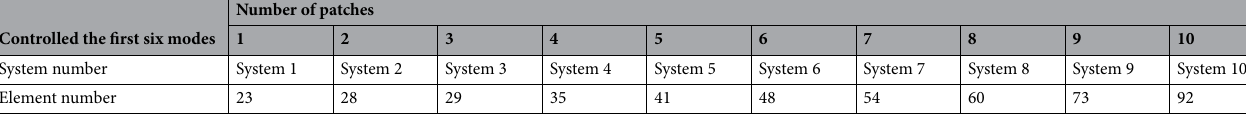
Table 6. Optimal placement of piezoelectric pairs installed to the rectangular thick plate.